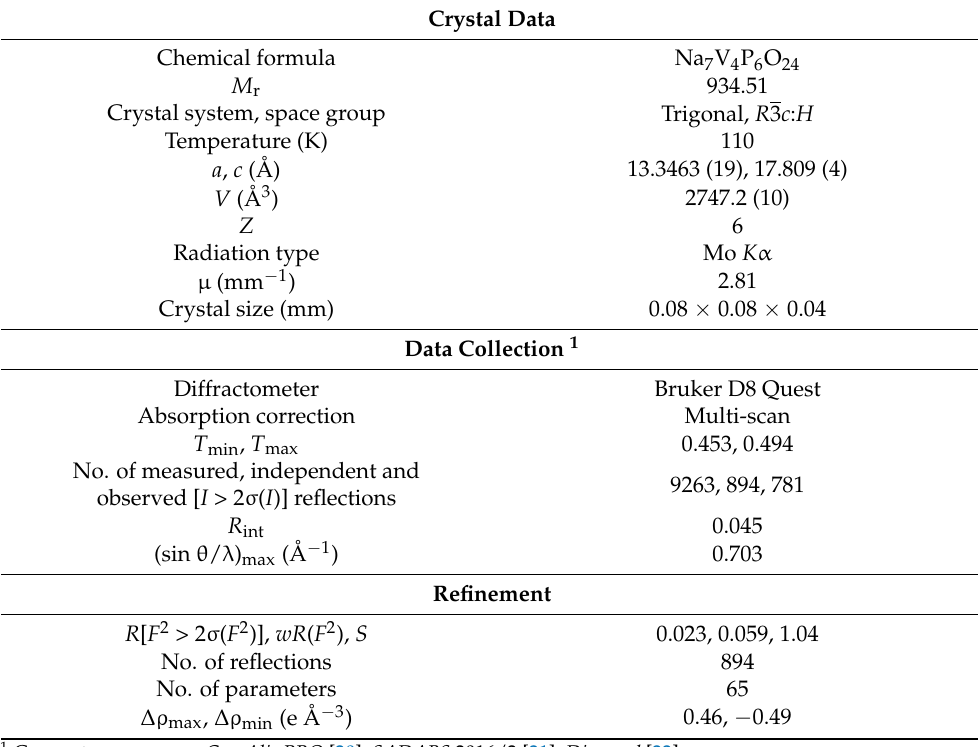
Table 1. Experimental details for Na 7 V 4 (PO 4 ) 6